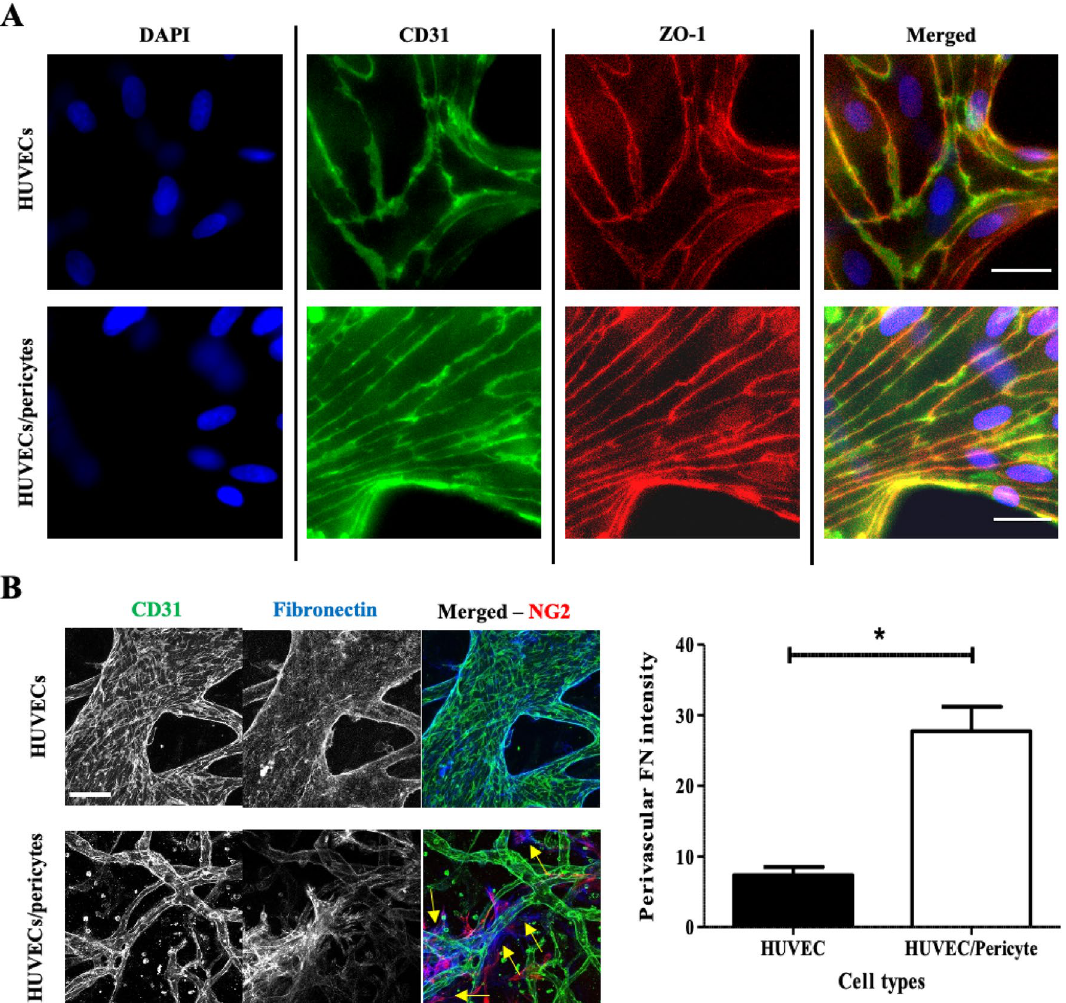
Figure 3. Vessel maturation markers. ( A ) Epifluorescence microscopy images of HUVECs or HUVECs/ pericytes vessel networks following 10-day culture, z-projection images were generated using epifluorescence images. These images represent a single Z-frame, displaying junction expression of CD31 and ZO-1. Blue, DAPI. Green, CD31. Red, ZO-1. Scale bar: 25 µm. ( B ) Images displaying fibronectin deposition, z-projection images were generated via confocal microscopy. Blue, Fibronectin. Green, CD31. Red, NG2. Scale bar: 100 µm. Right, quantification of fibronectin deposited in the perivascular space. Yellow arrows indicate some of the perivascular areas in which fibronectin deposition is apparent. N = 3; *, p <